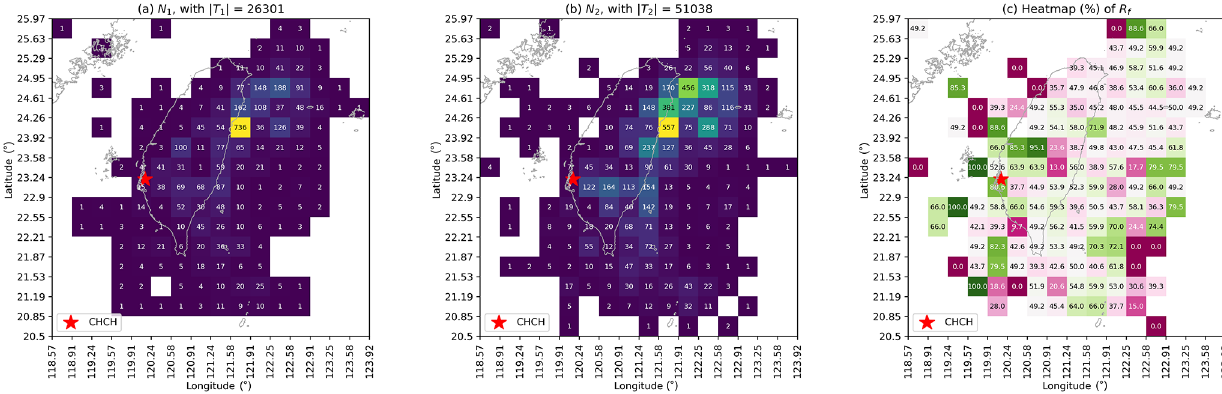
Figure 7. The step-by-step data visualization for CHCH, showing (a) the grid map with the number of M L ≥ 3 EQs during S 1 ’s time periods, N 1 ; (b) the grid map with the number of M L ≥ 3 EQs during S 2 ’s time periods, N 2 ; and (c) the grid map with the EQ frequency ratio, R F ( × 0 . 01 ) . Results were obtained using optimal hyperparameters: [ L w ,Q ] = [0 . 02 ( d ),